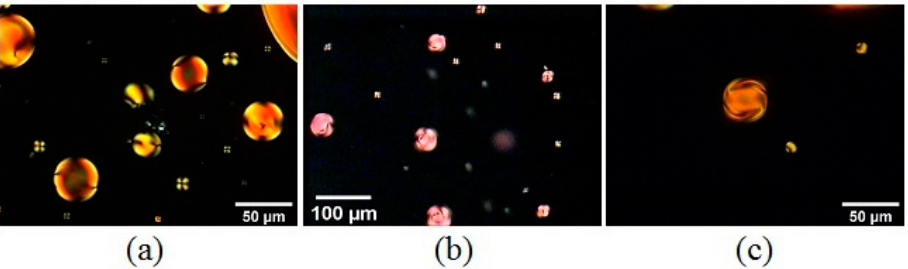
Figure 18. Sunset Yellow 30 wt% in paraffin oil doped with ( a ) L-alanine 10 wt%, ( b ) L-lysine 10 wt%. and ( c ) trans-Hyp 26 wt%. Reprinted with permission from ref. [50]. Copyright 2022, Elsevier.